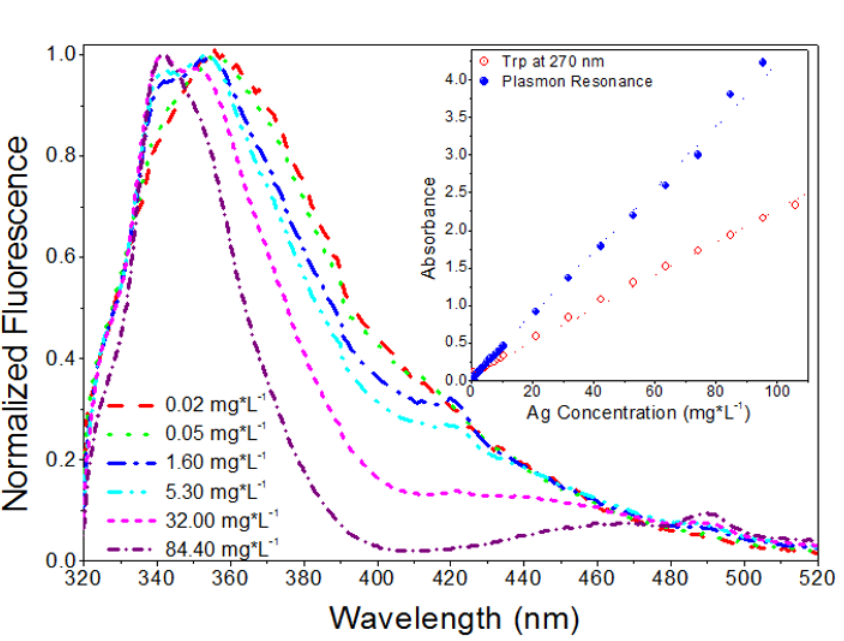
Figure 3. Increase in metal surface reabsorption as a function of silver nanoparticles concentration. The inset shows the linear dependence of tryptophan absorbance at 270 nm and plasmon resonance at 410 nm with the increase in silver nanoparticles concentration.